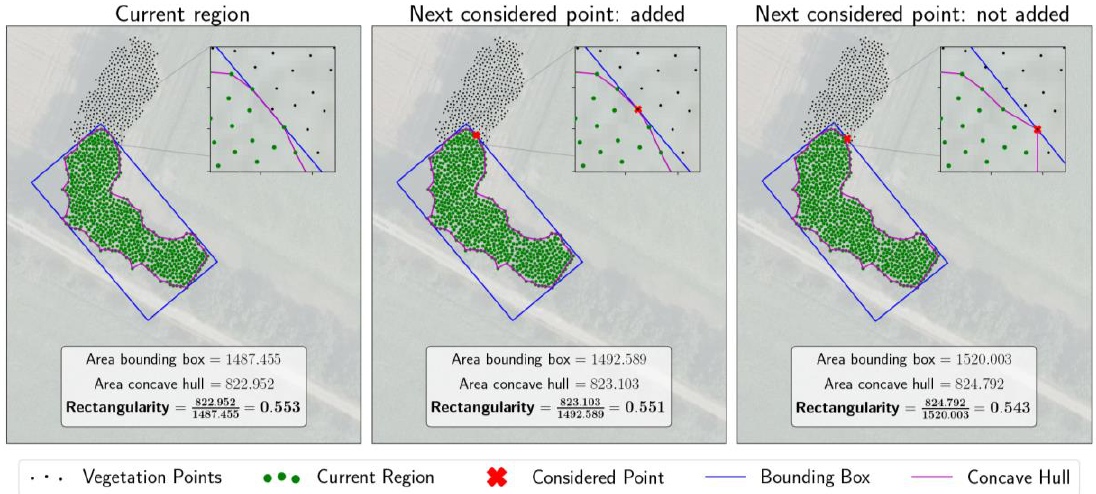
Figure 3. Visualization of the region growing process based on rectangularity in three steps. Step a shows how a current region (in green) is grown in which the ratio between the concave hull and bounding box is above the threshold of 0.55. Step b considers a next point (in red) to be included to the region, which is also accepted. Step c considers a next point, which does not meet the rectangularity constraint of 0.55 and is not added to that region.